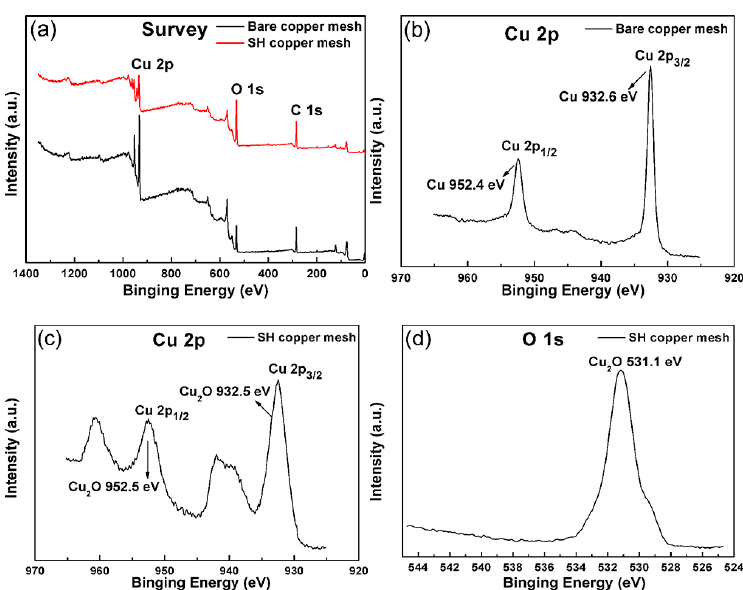
Figure 1. The XPS spectra of the bare and superhydrophobic copper mesh: survey ( a ), Cu 2 p of the bare copper mesh ( b ), Cu 2 p ( c ) and O 1 s ( d ) of the superhydrophobic copper mesh.